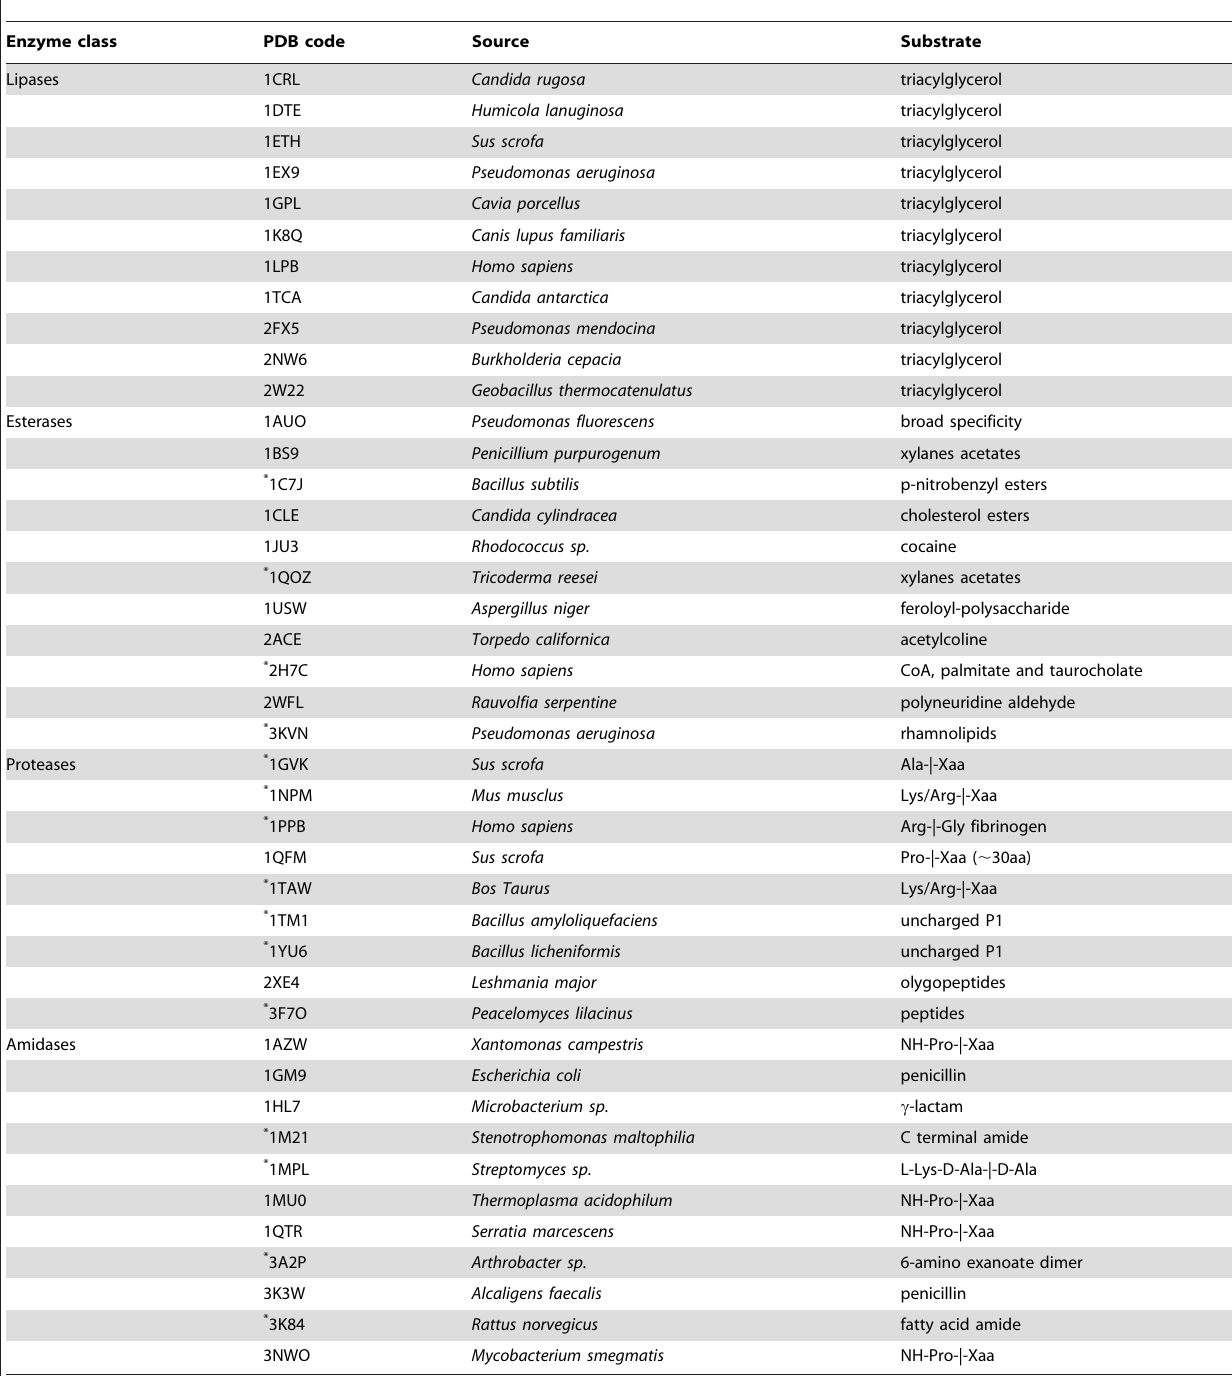
Table 1. Serine hydrolases considered in this work with details on enzyme